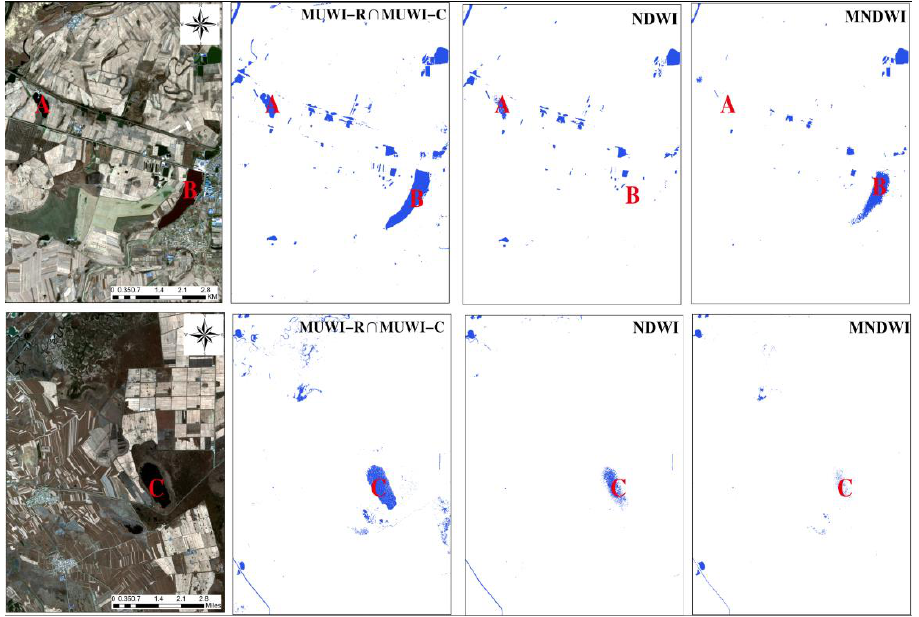
Figure 4. Sentinel-2 RGB image and corresponding water maps classified by spectral water indices, multispectral water index (MuWI)-R∩MuWI-C, modified normalised difference water index (MNDWI), and normalised difference water index (NDWI). Note: A, B, and C are the red box areas in Figure 3. (Location: Angxi District and Fuyu County of Qiqihar City).